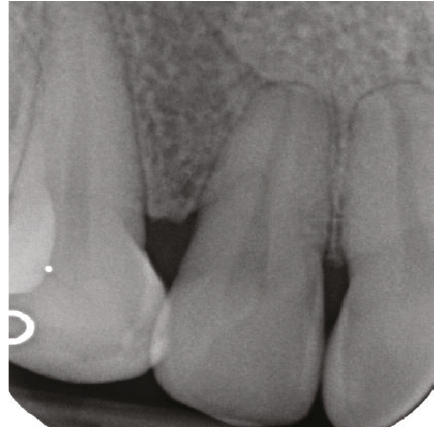
Figure 10: Radiographic examination after 12 months.